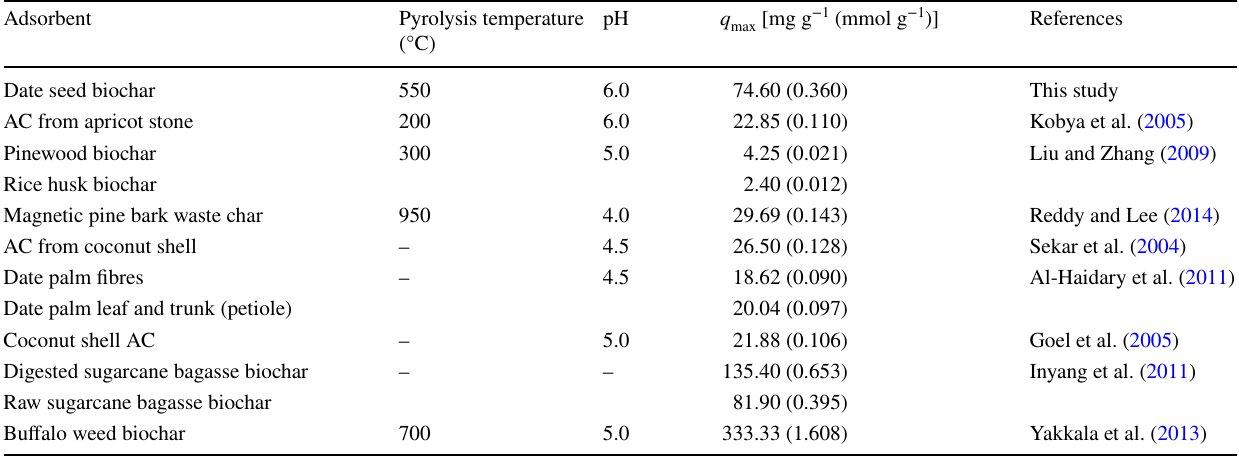
Table 5 Adsorption capacity towards Pb 2+ from aqueous solution